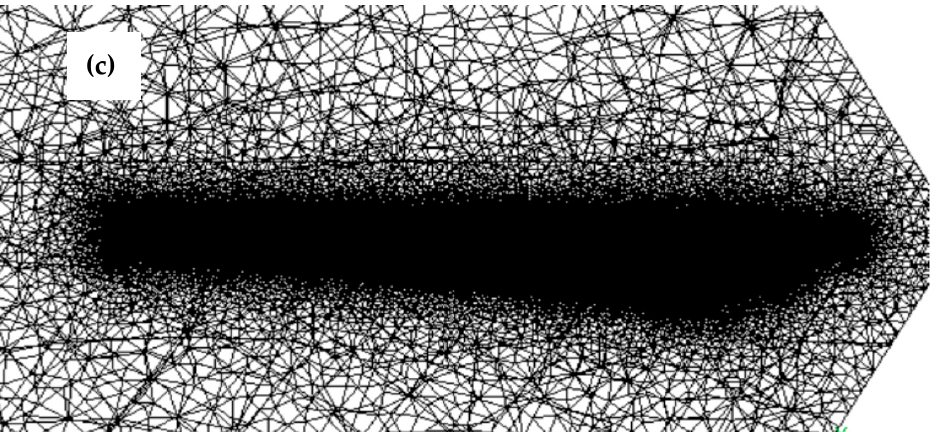
Figure 2. ( a ) Computational domain; ( b ) computational mesh generation, and ( c ) cell meshing around the rotor .